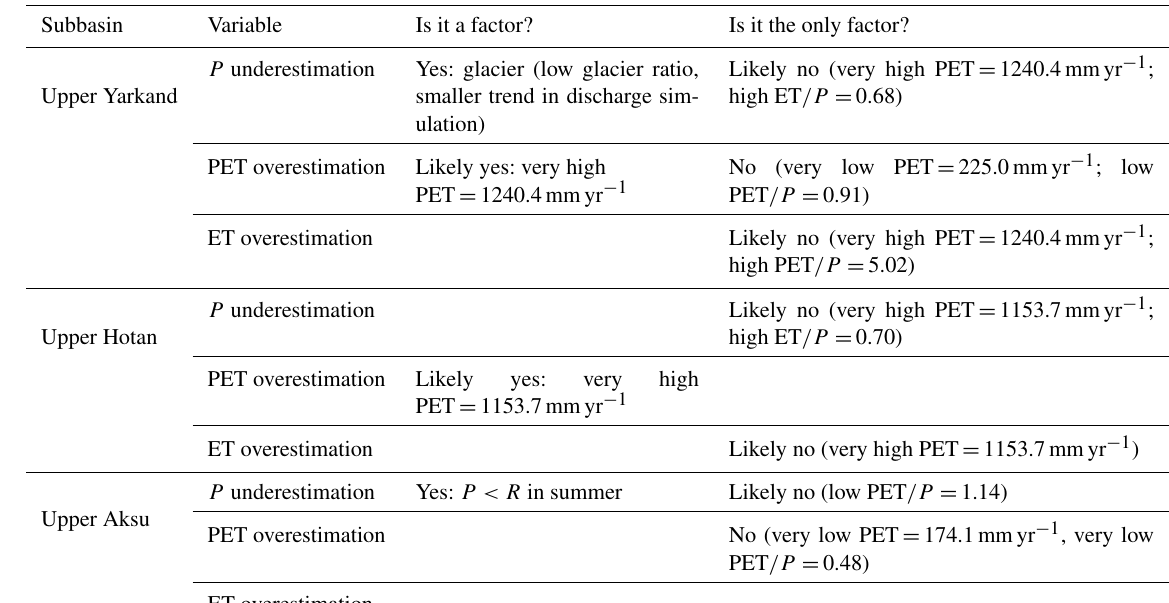
Table 6. Summary of the possible causes of the underestimation in discharge and the corresponding arguments. Three levels of the possibility are presented: yes: with direct argument; likely: with indirect argument; and no: with negative argument.